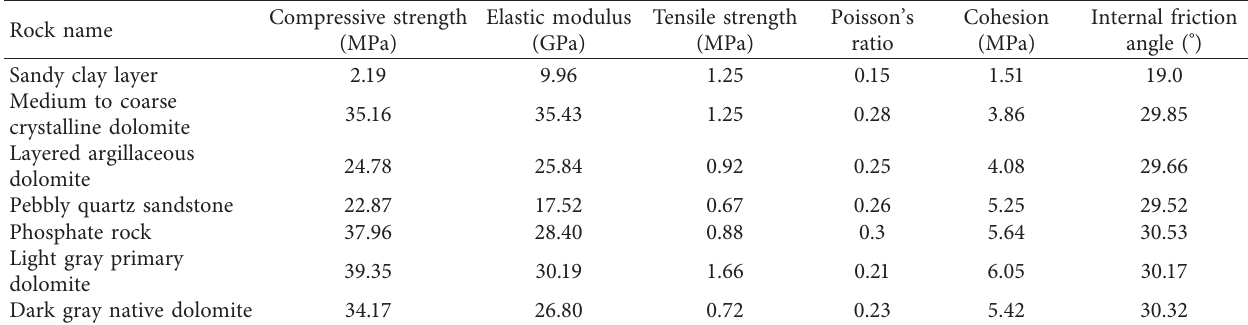
Figure 9: Numerical simulation physical model. (a) Schematic diagram of the layout of monitoring points for mine rooms and pillars. (b) Stress distribution in the initial state of rock Table 3: Rock mechanics parameters.